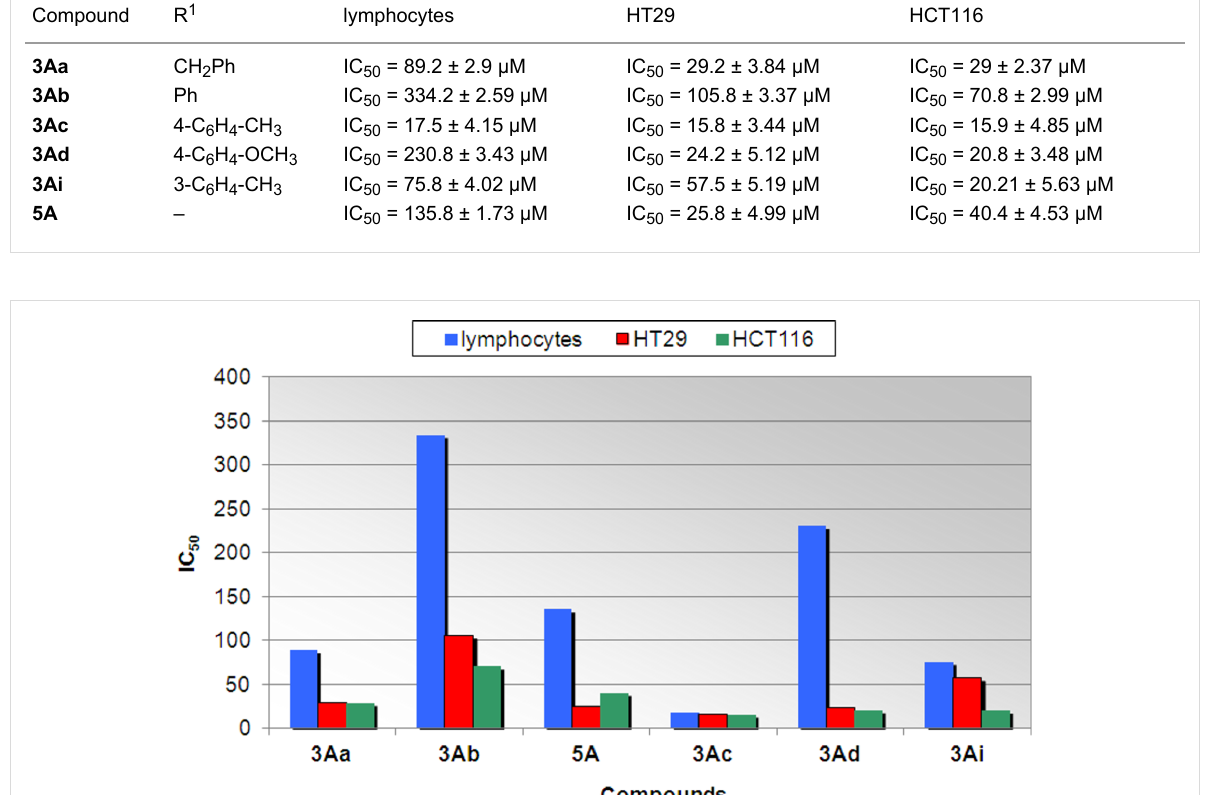
Table 2: IC 50 values on studied compounds.